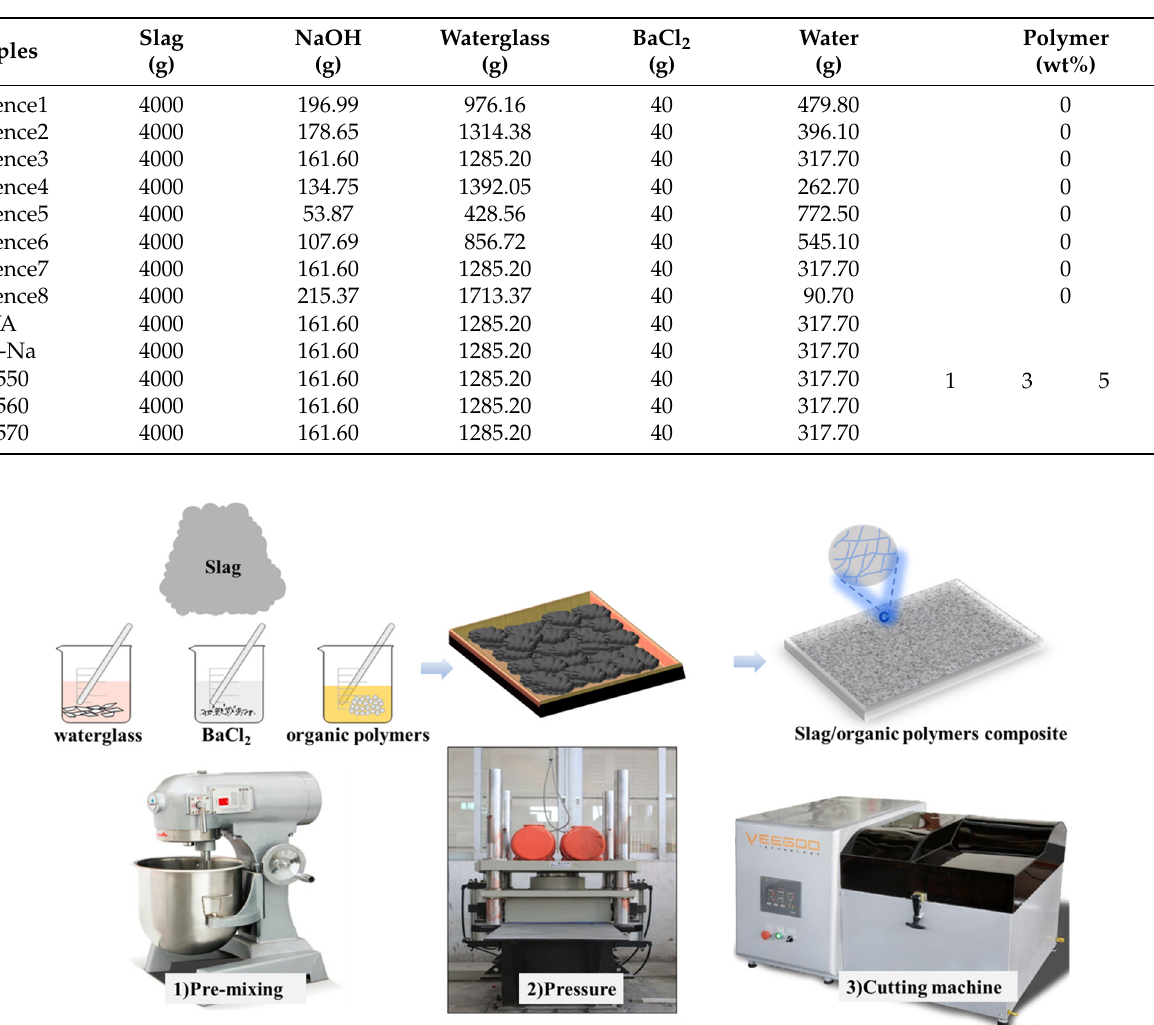
Table 2. Mixing proportions of organic–inorganic composite geopolymer paste.